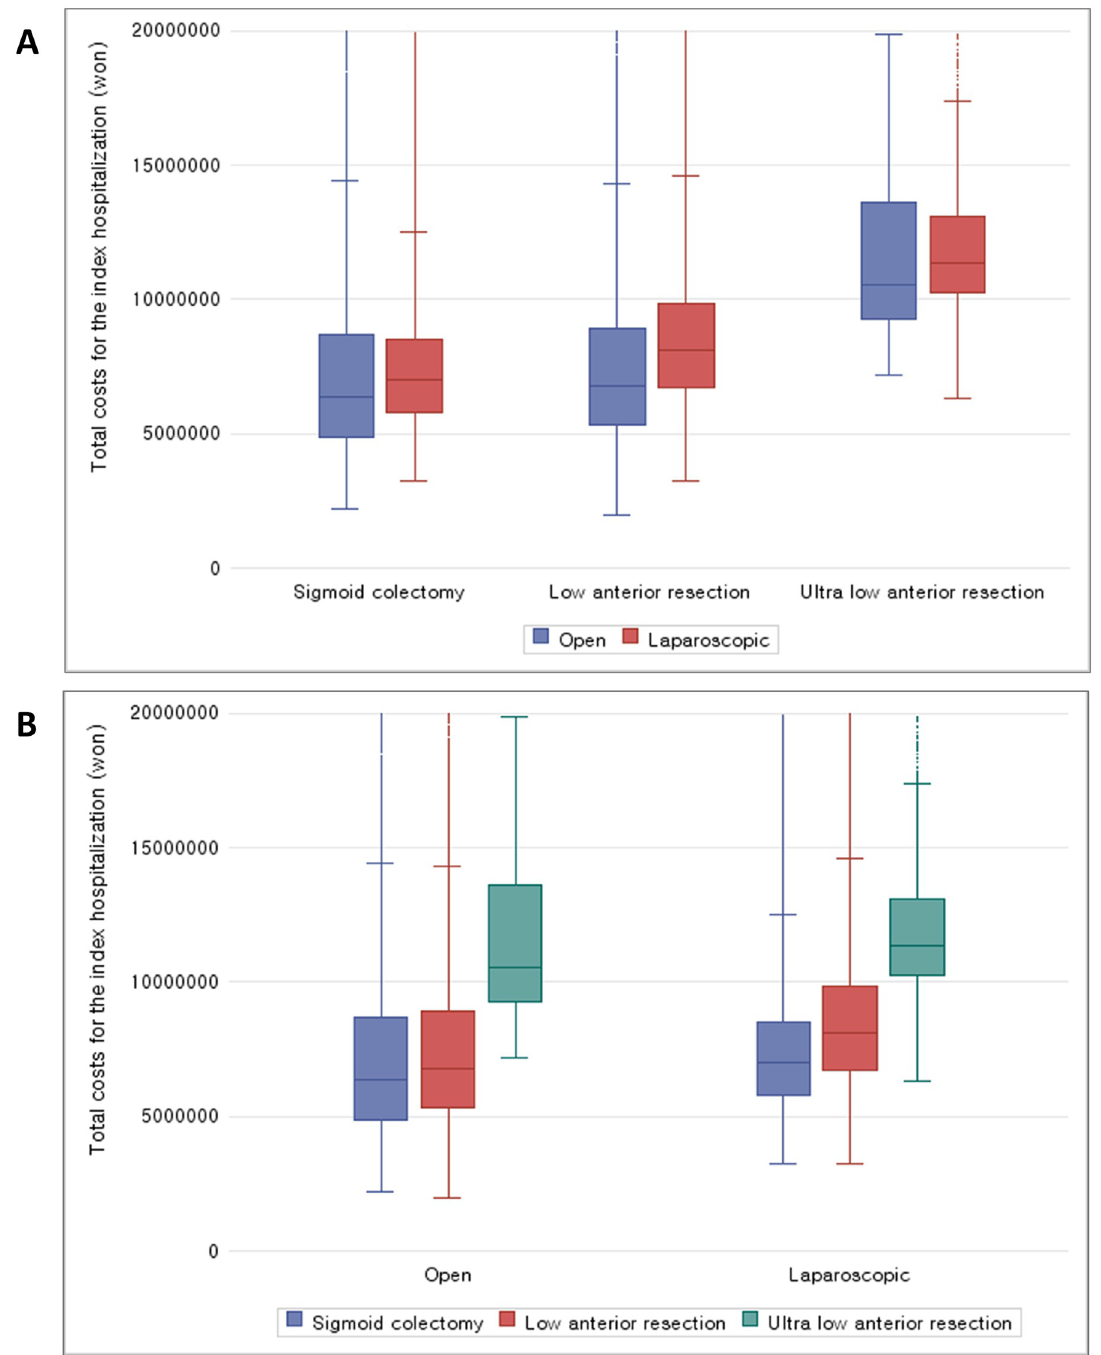
Fig 2. Healthcare costs by procedure & approach. The clipped boxplot trimmed extremely high values based on 20,000,000 KRW. (1 U.S. dollor = 1,150 Korean won) (A) The number of clipped patients in open anterior resection = 256; The number of clipped patients in laparoscopic anterior resection = 334; The number of clipped patients in open low anterior resection = 432; (B) The number of clipped patients in laparoscopic low anterior resection = 792; The number of clipped patients in open ultra-low anterior resection = 17; The number of clipped patients in laparoscopic ultra-low anterior resection =